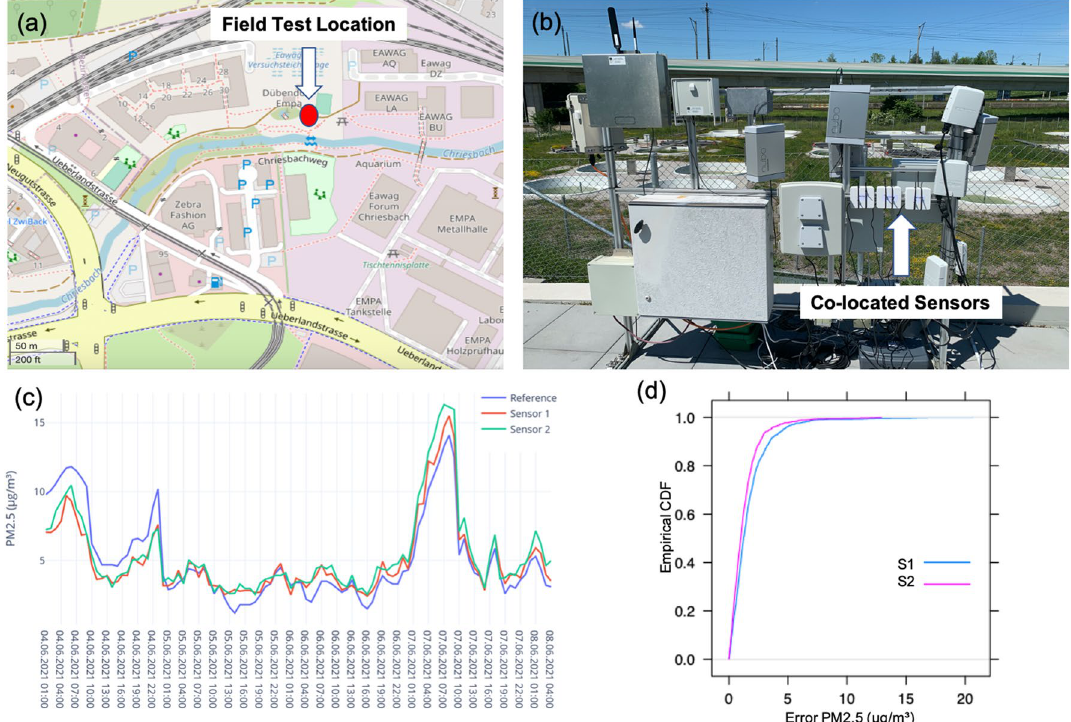
Figure 6. ( a ) Red dot on the map shows the field test location, ( b ) Co-location setup at NABEL monitoring station, ( c ) Line plot of PM2.5 data obtained from two CoSense Units located with the reference monitor at NABEL station, and ( d ) CDF of the difference between the PM2.5 values recorded by the reference monitor and two sensors (S1 and S2).